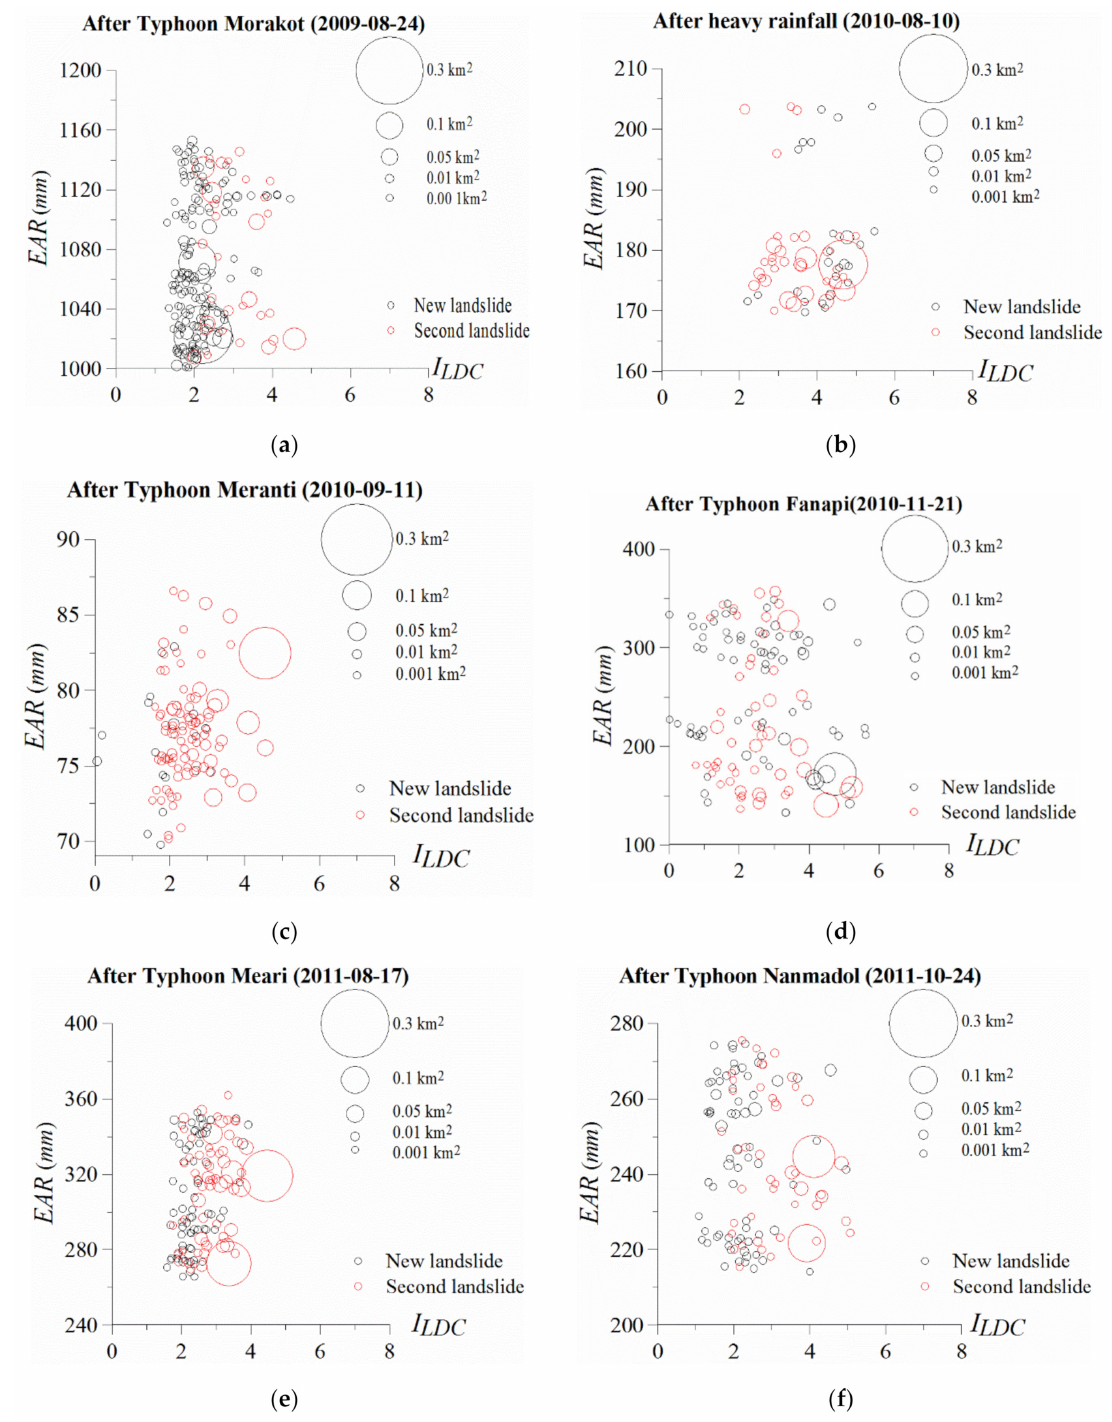
Figure 10. Plot of EAR against I LDC for both the new landslide and second landslide after ( a ) Typhoon Morakot (2009), ( b ) heavy rainfall on 27 July 2010, ( c ) Typhoon Meranti (2010), (d) Typhoon Fanapi (2010), ( e ) Typhoon Meari (2011), and ( f ) Typhoon Nanmadol